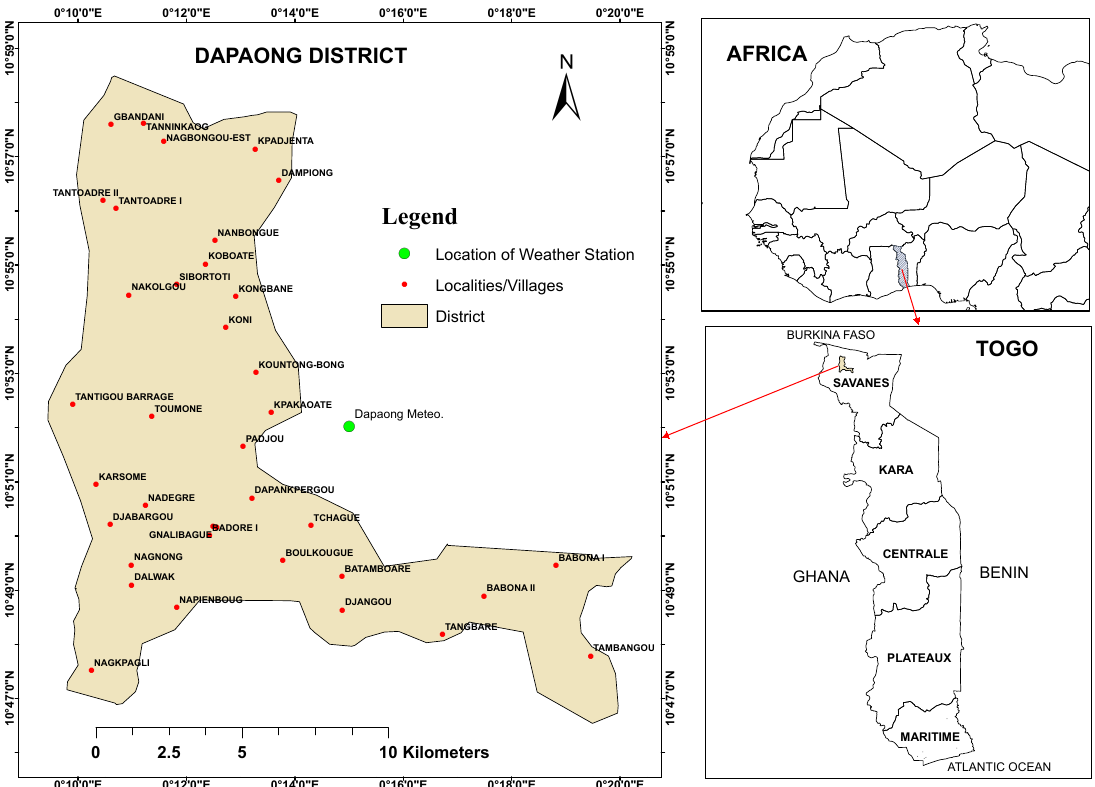
Figure 1. Map of northern Togo indicating the study area (Dapaong